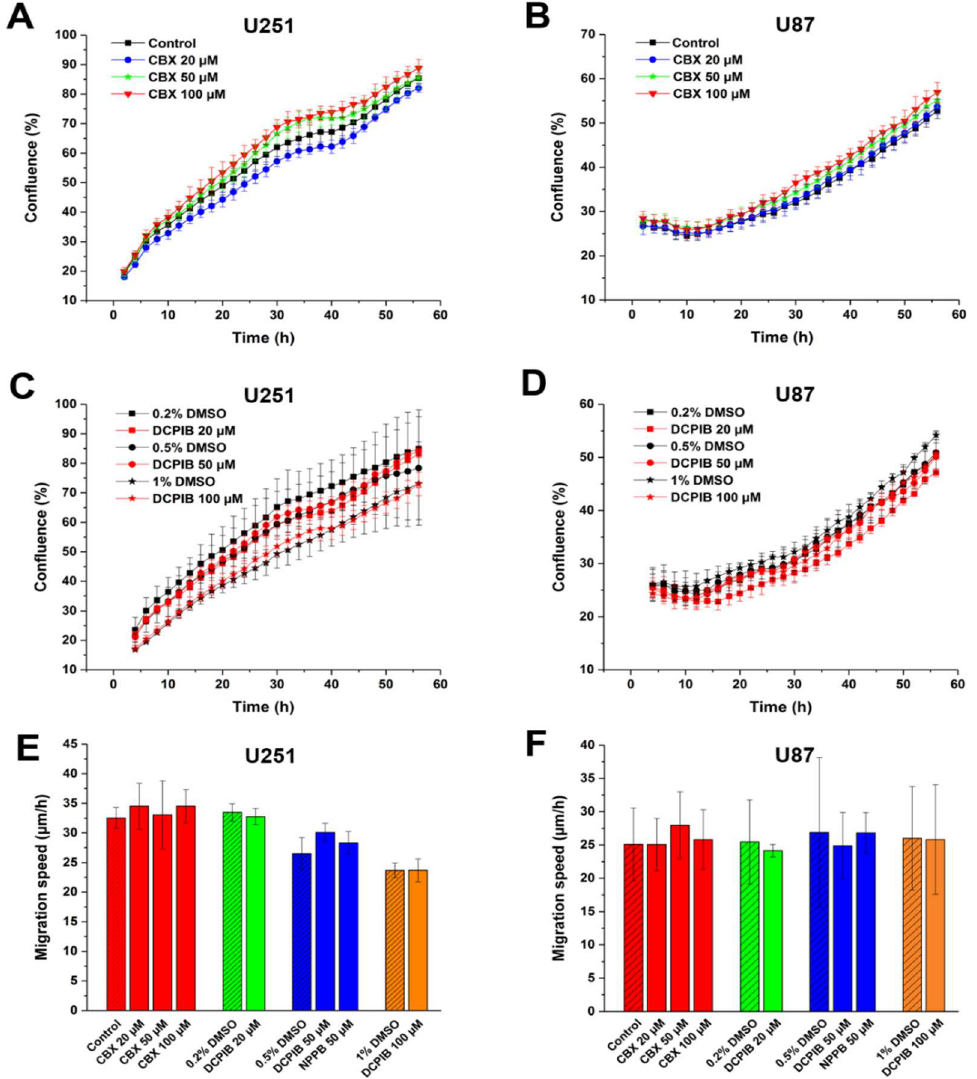
Figure 3. Volume-regulated anion channel (VRAC) blockers do not affect proliferation and migration of glioblastoma multiforme (GBM) cells. Growth curve of U251 ( A , C ) and U87 ( B , D) after treatment with indicated concentrations of CBX ( A , B ) or DCPIB ( C , D ). Data represent mean ± SD of n = 3–7 experiments. Cell migration of U251 ( E ) and U87 ( F ) after treatment with indicated concentrations of CBX, NPPB or DCPIB. The diagonal lines represent controls. Data represent mean ± SD of n = 4–10 experiments. Together, these results from pharmacological VRAC inhibition and LRRC8A knockdown suggest that VRAC is dispensable for glioblastoma cell proliferation and migration in the wound healing